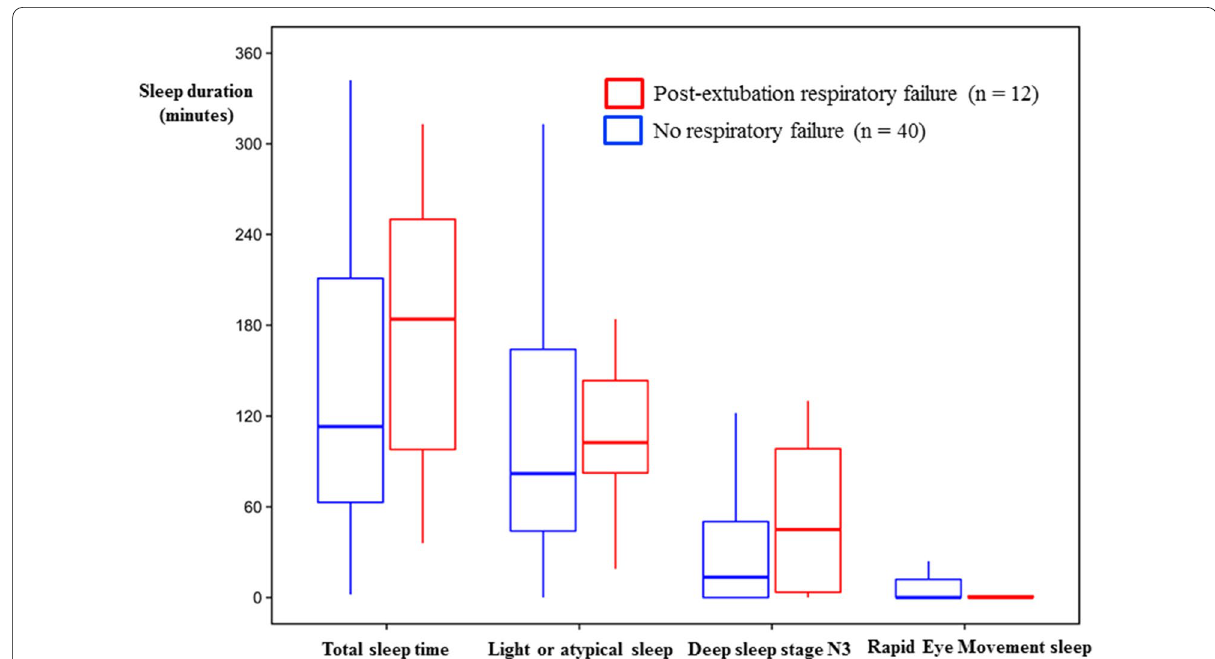
Fig. 3 Box plots showing median duration and interquartile range [IQR 25th–75th percentiles] of total sleep, light or atypical sleep, deep sleep stage 3 and rapid eye movement (REM) sleep stage. No significant differences were found between patients who developed post‑extubation respiratory failure (red bars) and those who were successfully extubated (blue bars)